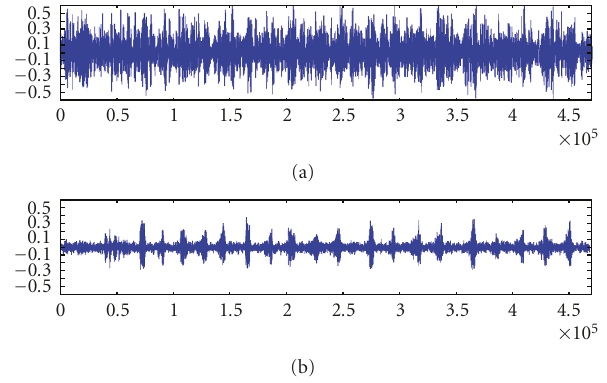
Figure 4: An example of the segregation of a user’s voice from surrounding noise sources. (a) Waveform of mixed sounds. (b) Waveform of segregated user